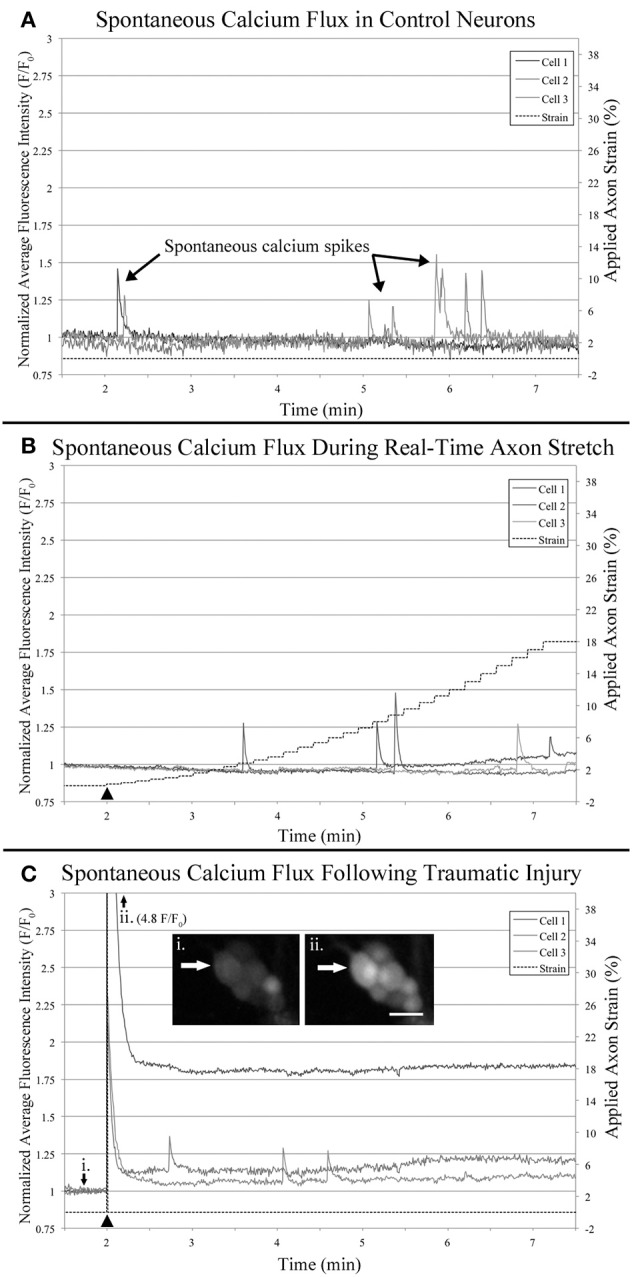
Functional calcium imaging. Cells were loaded with Fluo-4AM and imaged over 10 min time-lapse sequences which were quantified and plotted. All cells which spiked during the first minute of recording were excluded from analysis to reduce background noise. Examples plots represent: (A) Control neurons within sham bioreactors, (B) Neurons undergoing real-time stretch, and (C) Stretch-injured cells subjected to 40% strain over 30 s−1, (i) before injury, (ii) immediately after injury. Bar = 25 μm.